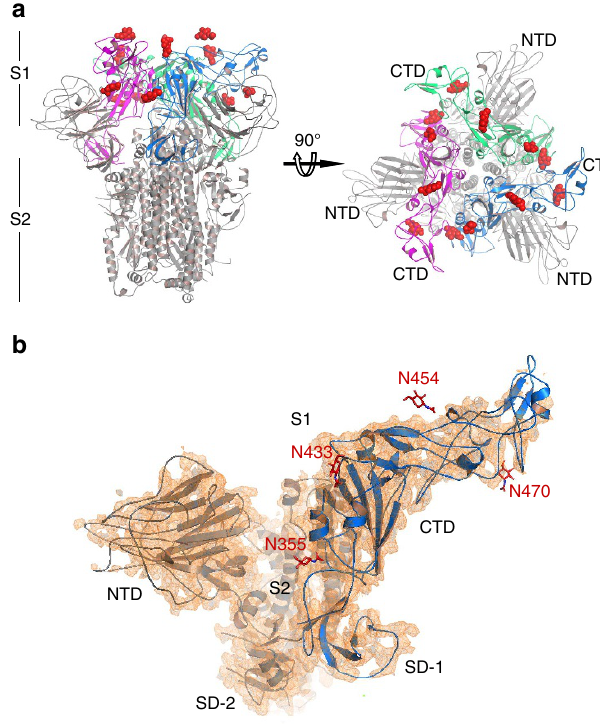
Figure 4 | Integrated model of HKU1 S protein trimer with the crystal structure of 1A-S310-677aa. ( a ) The trimeric model of HKU1 S protein with the crystal structure of 1A-S310-677aa. (left) side view; (right) top view. The model is built by superimposing the crystal structure of 1A-S310-677aa into the Cryo-EM structure of the HKU1 S protein trimer 18 based on the structure alignment of the core subdomain. The cryo-EM structure of the trimeric HKU1 S protein is shown in grey. The three crystal structures of 1A-S310-677aa are labelled in blue, magenta and green, respectively. The red spheres are sugar moieties found in the crystal structure of 1A-S310-677aa. ( b ) Superimposition of 1A-S310-677aa onto the cryo-EM density of the HKU1 S protein. The crystal structure of 1A-S310-677aa is shown in blue and the cryo-EM density map is shown in orange. N-linked glycan moieties are shown in red